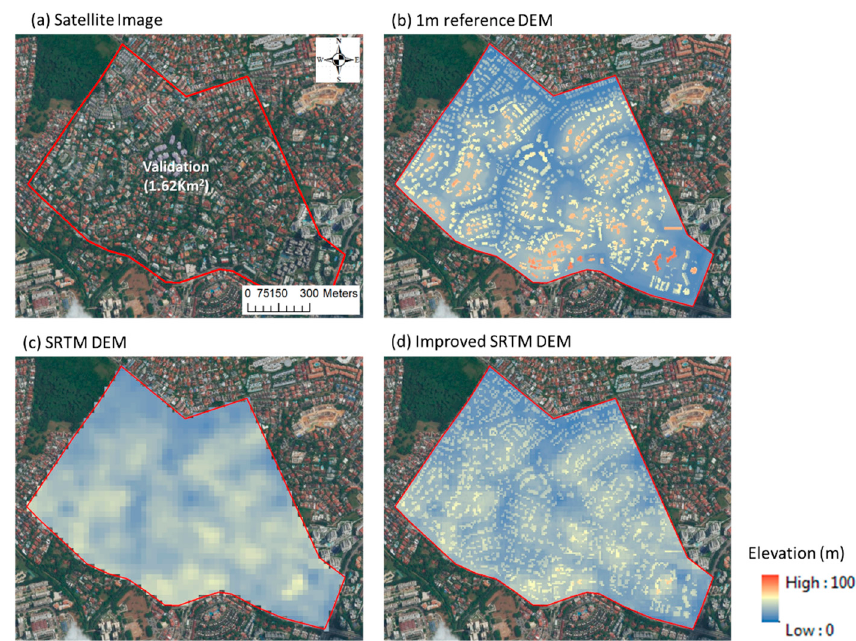
Figure 7. Comparisons of ( a ) satellite image, ( b ) 1 m reference DEM, ( c ) SRTM DEM, and ( d ) iSRTM DEM in dense urban area in Singapore.